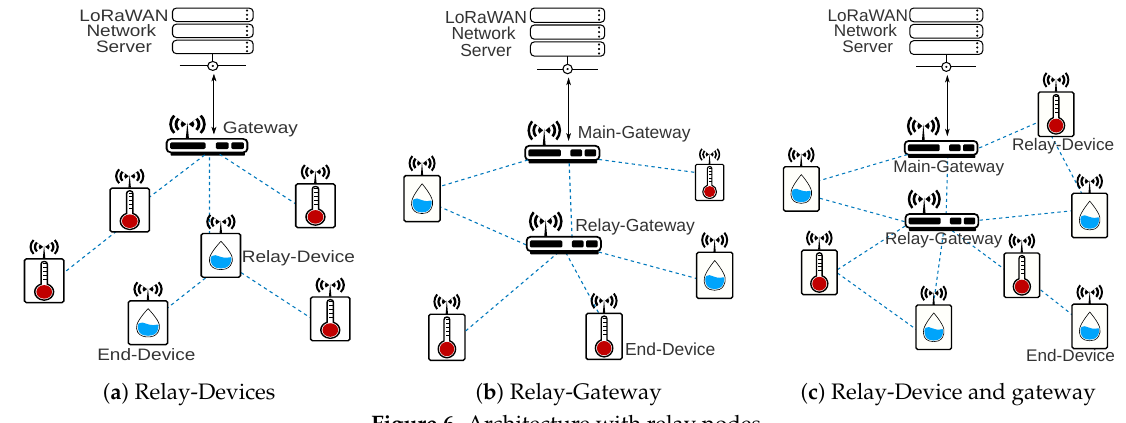
Figure 6. Architecture with relay